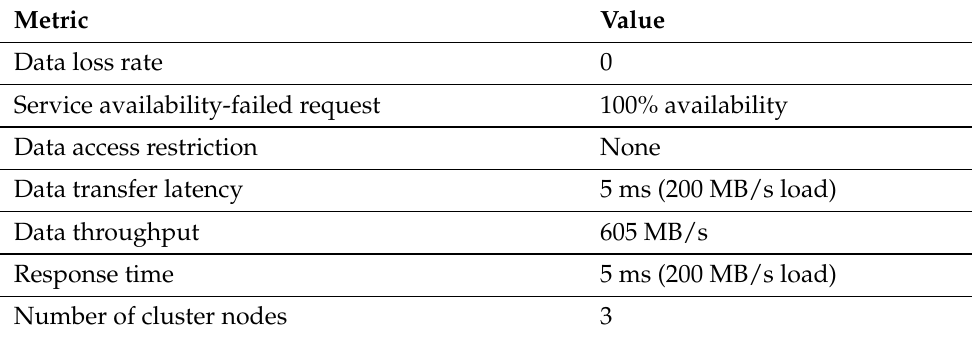
Table 2. Results of the measurements for DFB